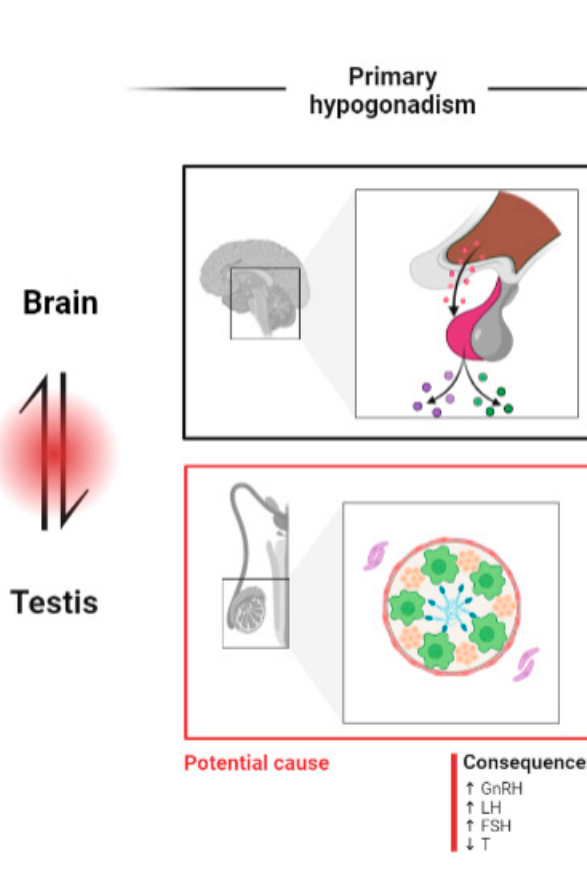
Figure 2. Pathological differentiation of the main types of hypogonadism in males. Male